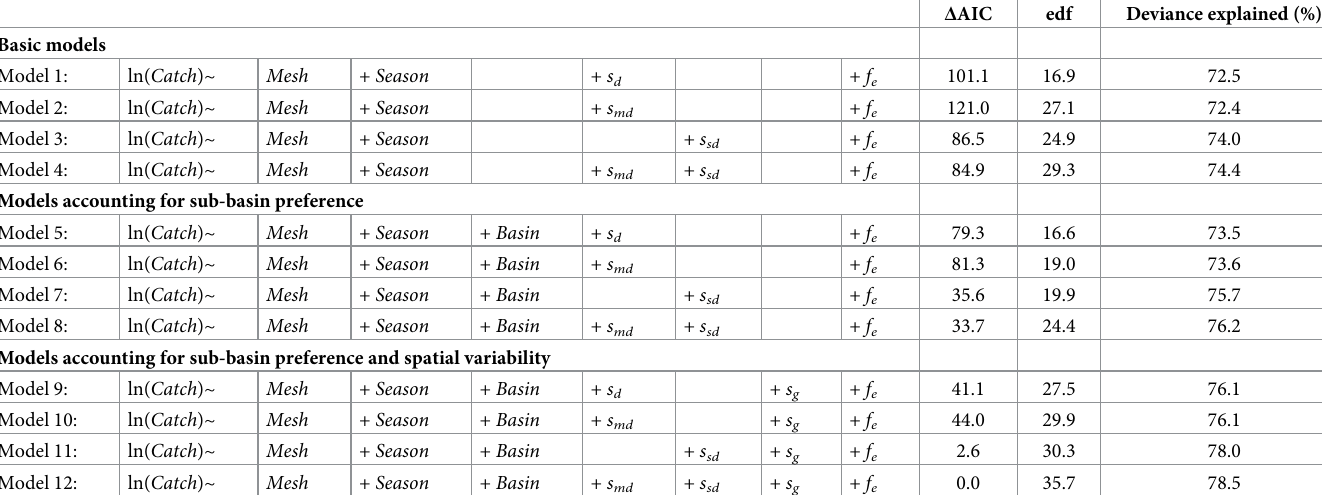
Table 2. Results for the selection of Generalized Additive Models (GAM) fitted to the Fulmar data.